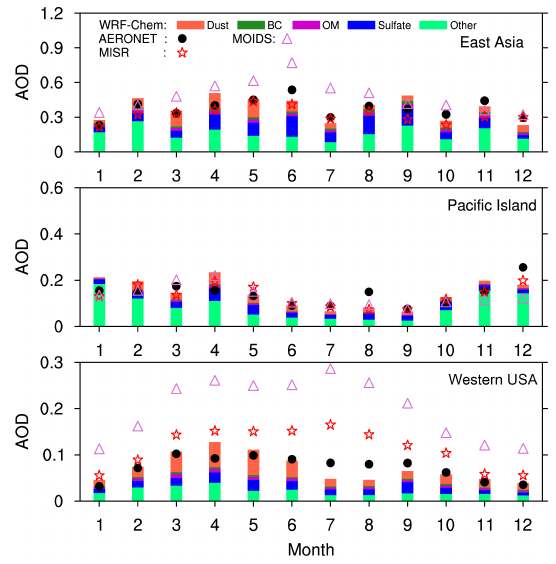
Figure 7. Monthly mean 550nm AOD from AERONET (black dots), MODIS (purple triangles), MISR (red five-pointed stars) and the corresponding WRF-Chem simulation (histogram) averaged for the period 2010–2014 at the eastern Asian, the Pacific island, and the western USA sites as shown in Fig.